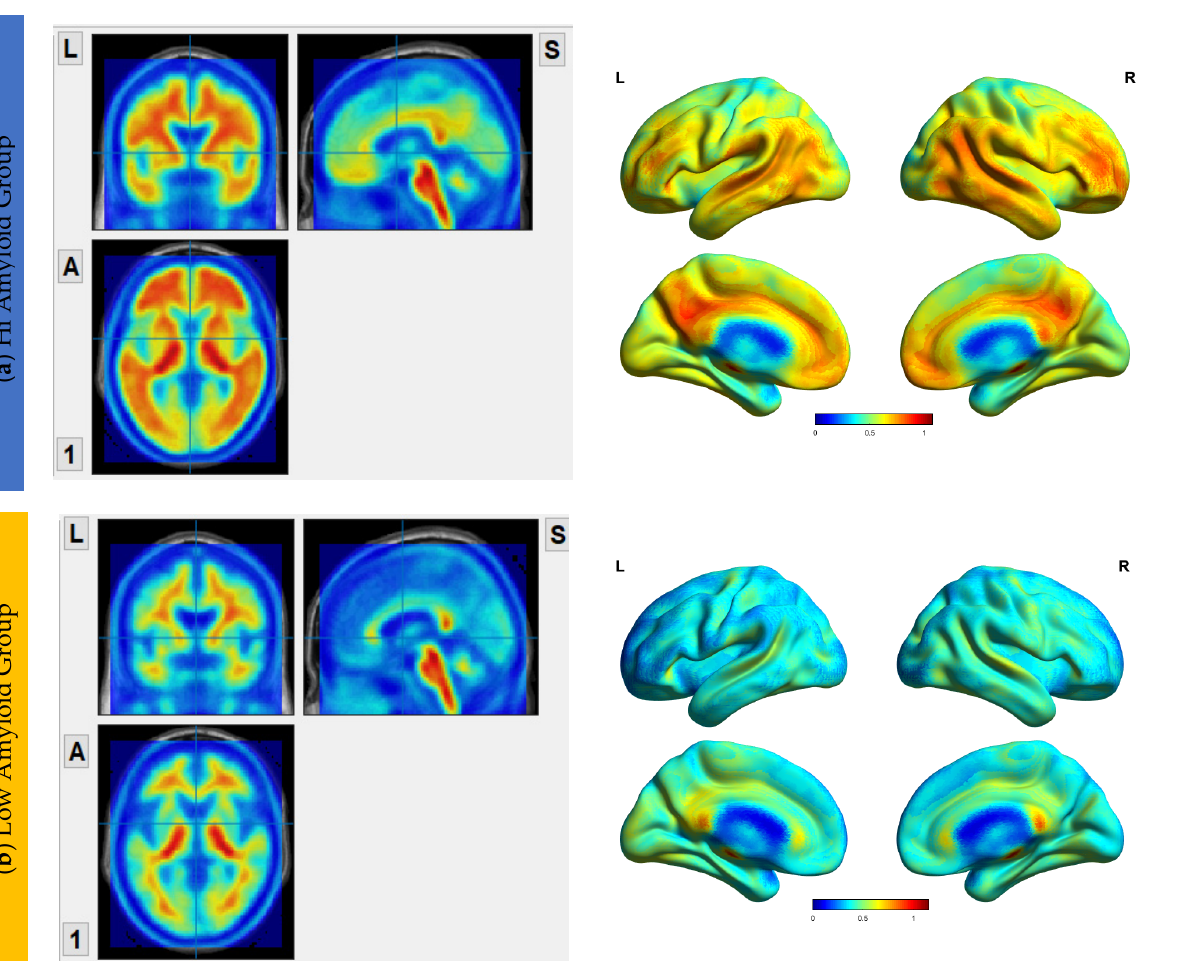
Table 1. Demographics of participants.